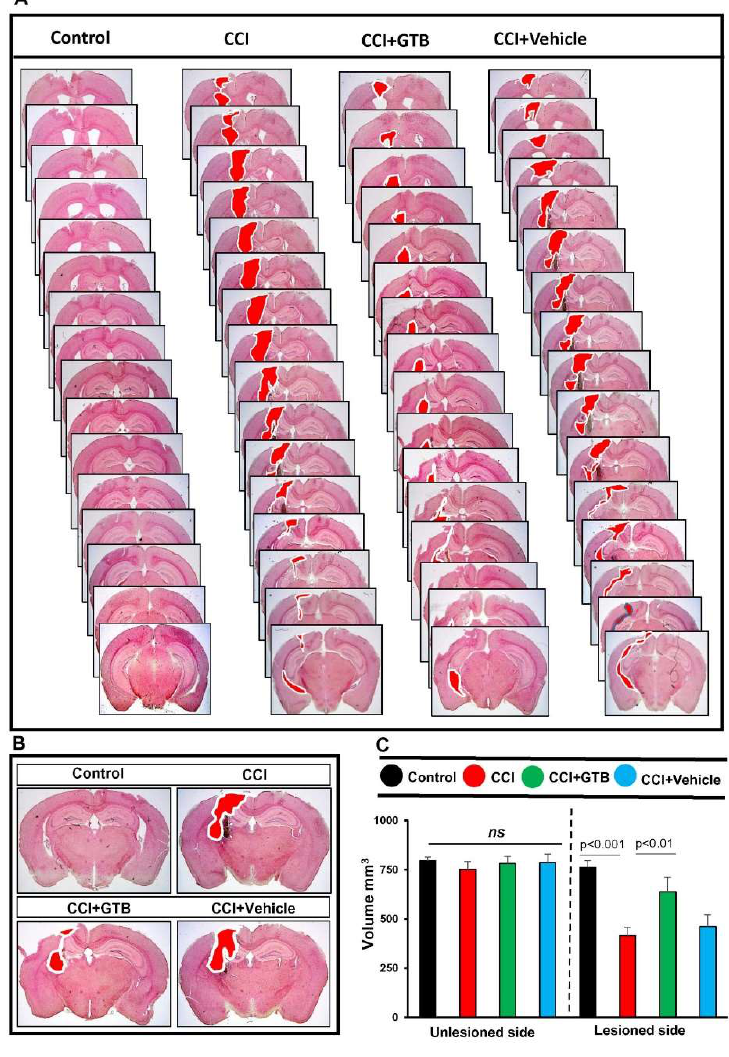
Figure 3. Decrease in lesion volume in TBI mice by GTB treatment. TBI was induced in mice by CCI injury and after 24 h of injury, mice were treated with 50 mg/kg/day of GTB via oral gavage. ( A ) Twenty-one days after injury, brain sections were stained with H&E and the stained sections were arranged in a series demonstrating the volume of lesion cavity in different groups. ( B ) Illustrative images of H&E stained sections are shown. ( C ) Lesion volume was quantified in all groups of mice. Statistical analyses were performed with two-way ANOVA and expressed as mean ± SD to compare the lesion volume between non-lesioned and lesioned side of the